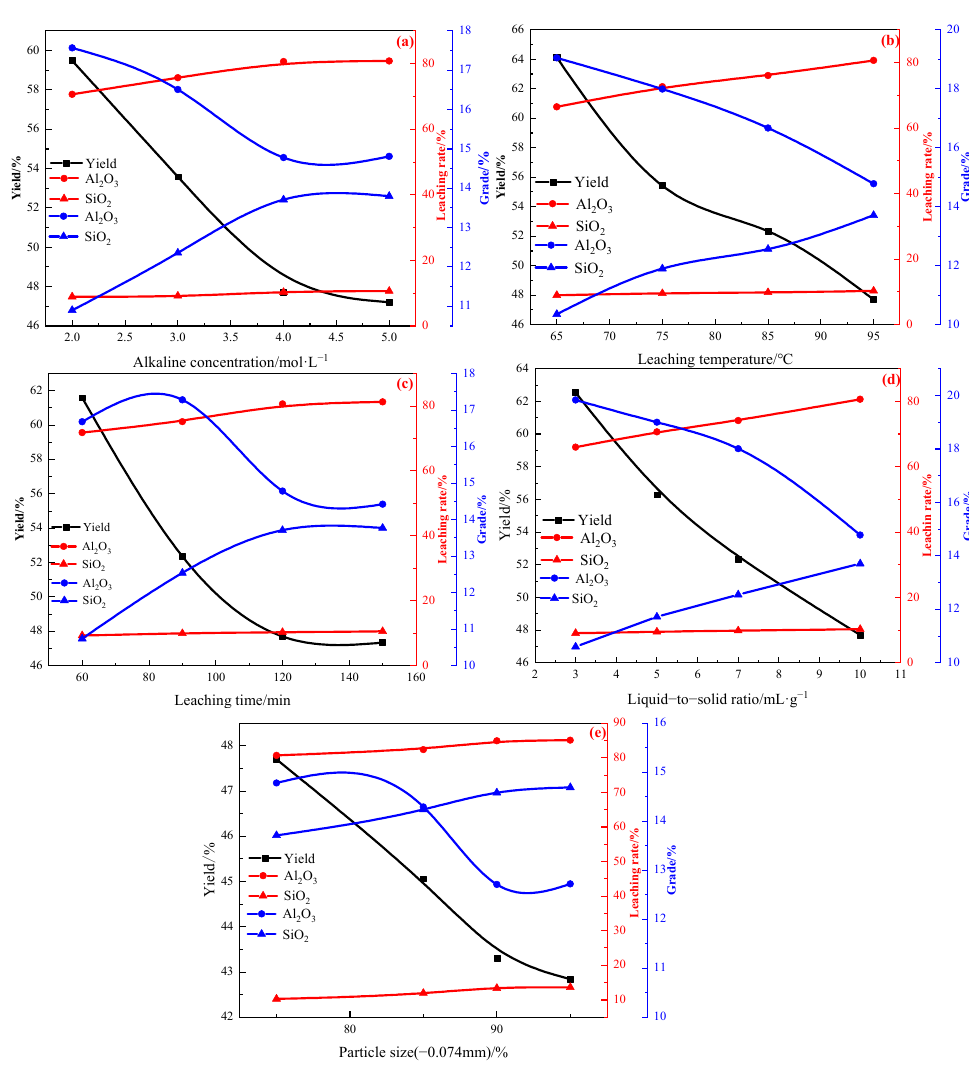
Figure 9. Plots of lnk versus 1/T of the Al 2 O 3 leaching rate.